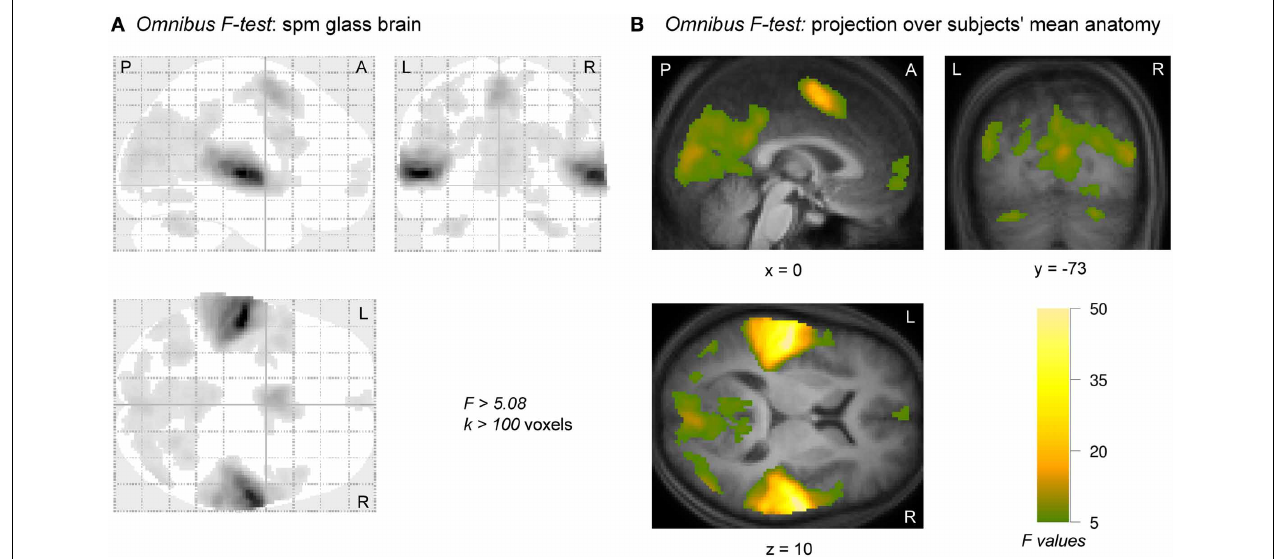
FIGURE 3 | Activation and deactivation to all conditions relative to baseline according to an omnibus F -test. Activation clusters were observed in right and left auditory cortices. Visual and motor-related areas were also active as was a small region in frontal cortex. (A) A “glass brain” image,